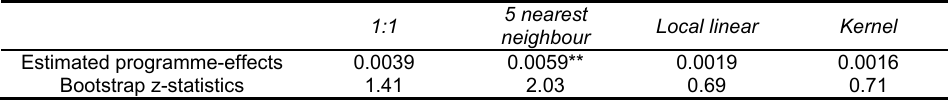
Table 4: Raw programme effects estimated with matching